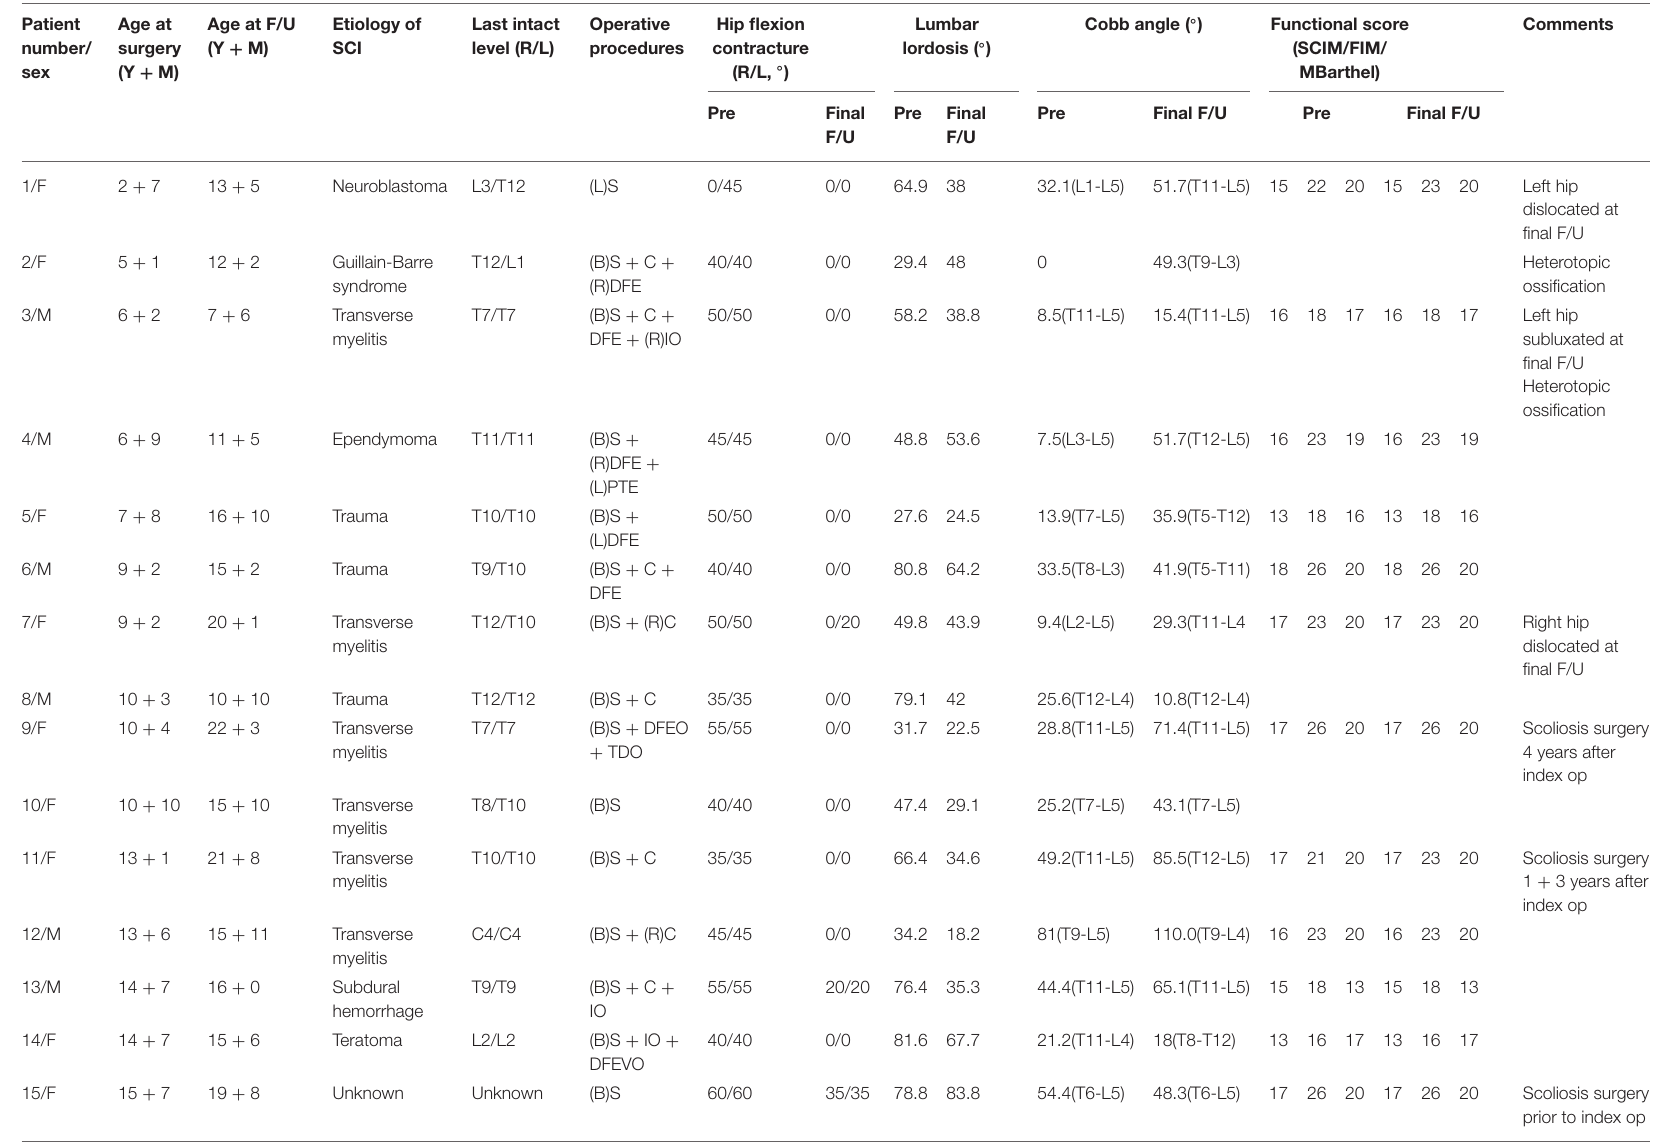
TABLE 1 | Information of patients.